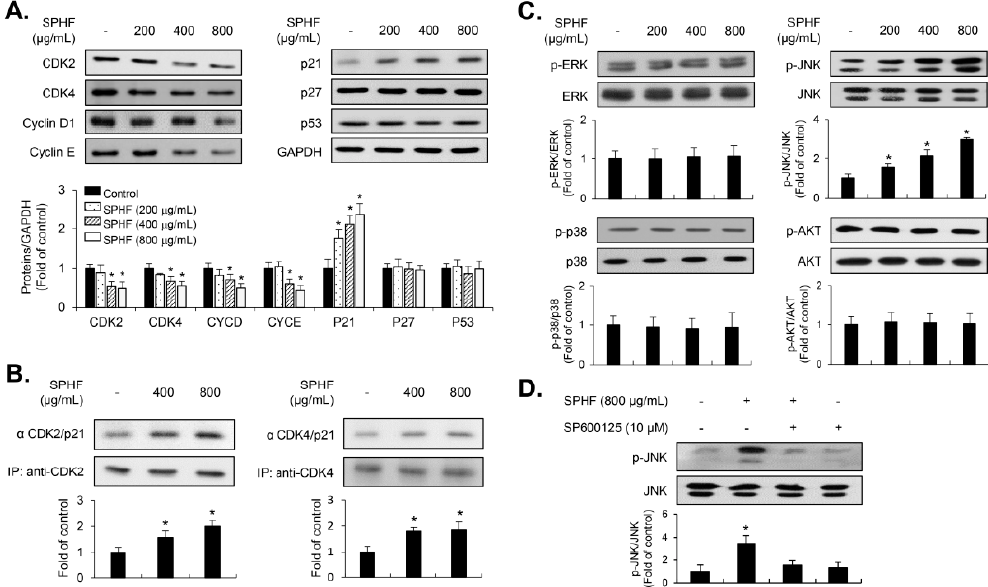
Figure 3. Involvement of cell-cycle regulators and signaling molecules during SPHF-induced suppression of EJ cell proliferation. EJ cells were treated with the indicated concentrations of SPHF for 24 h. ( A ) Immunoblot analysis of cell cycle-associated proteins in SPHF-treated EJ cells. GAPDH was utilized as an internal control. ( B ) Cell lysates were immunoprecipitated with anti-CDK2 and anti-CDK4 antibodies, after which immunoblot analysis was performed using an anti-p21WAF1 antibody. ( C ) Phosphorylation levels of MAPKs (ERK1 / 2, JNK, and p38MAPK) and AKT were measured via immunoblot analysis. ( D ) JNK phosphorylation specificity was evaluated via immunoblot analysis using its specific kinase inhibitor SP600125. The bar graphs present fold changes in expression levels compared to the controls. Values are presented as the mean ± SD of three independent experiments; * p < 0.05 relative to the non-treated